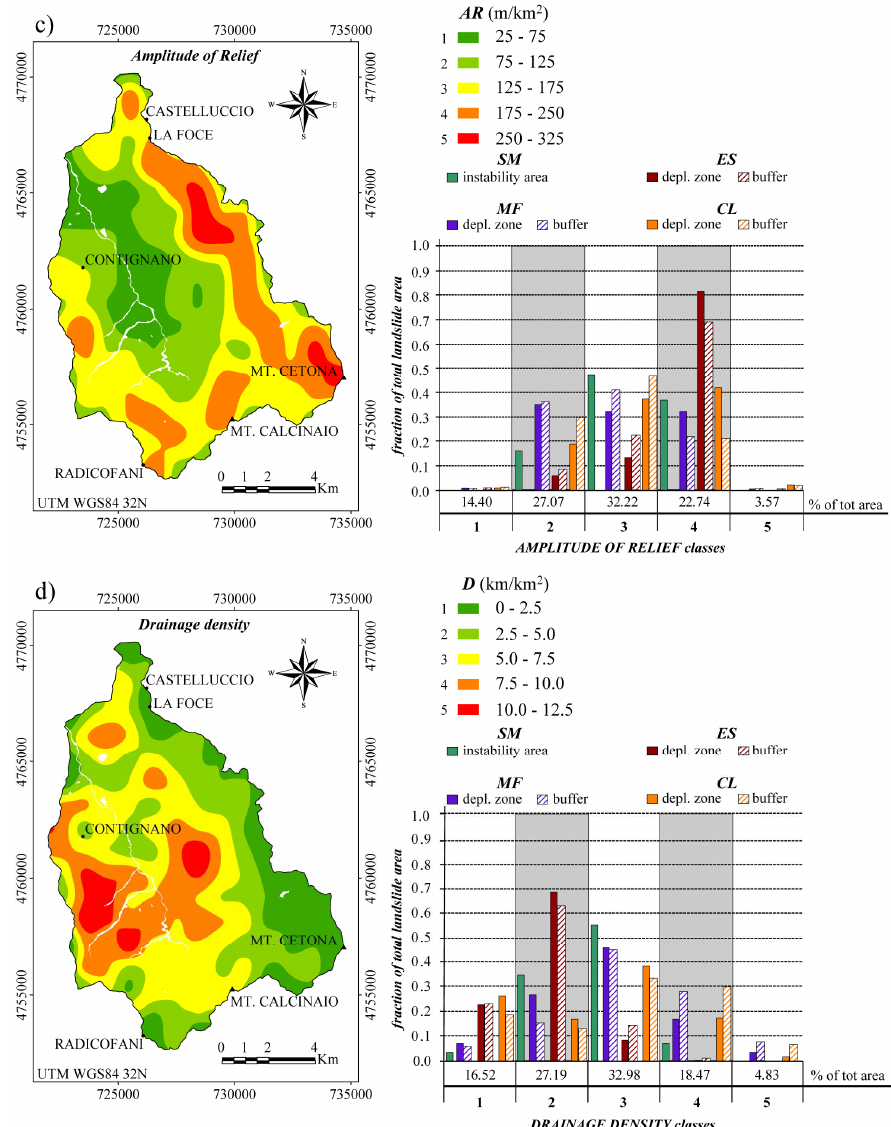
Fig. 6. ( c, d) Thematic maps showing the spatial distribution of potential causal factors for landslides: (a) Slope ( S ); (b) Aspect ( A ); (c) Amplitude of Relief (AR); (d) Drainage density ( D ); (e) Land Use (LU); (f) Lithology ( L ). The values of each variable were classified and, for each landslide type, the fraction of the total landslide area within each factor class is reported in the